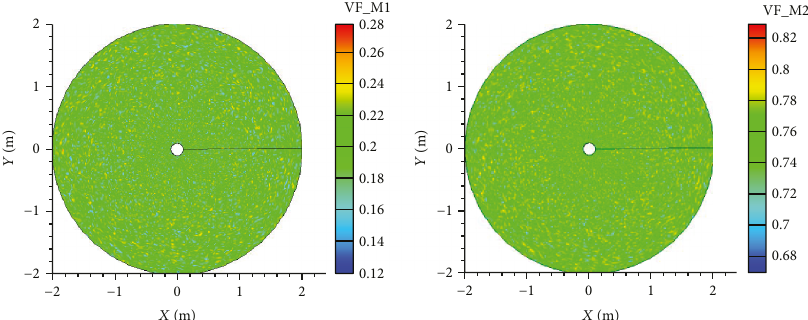
Figure 4: Distribution of the volume fraction ( V